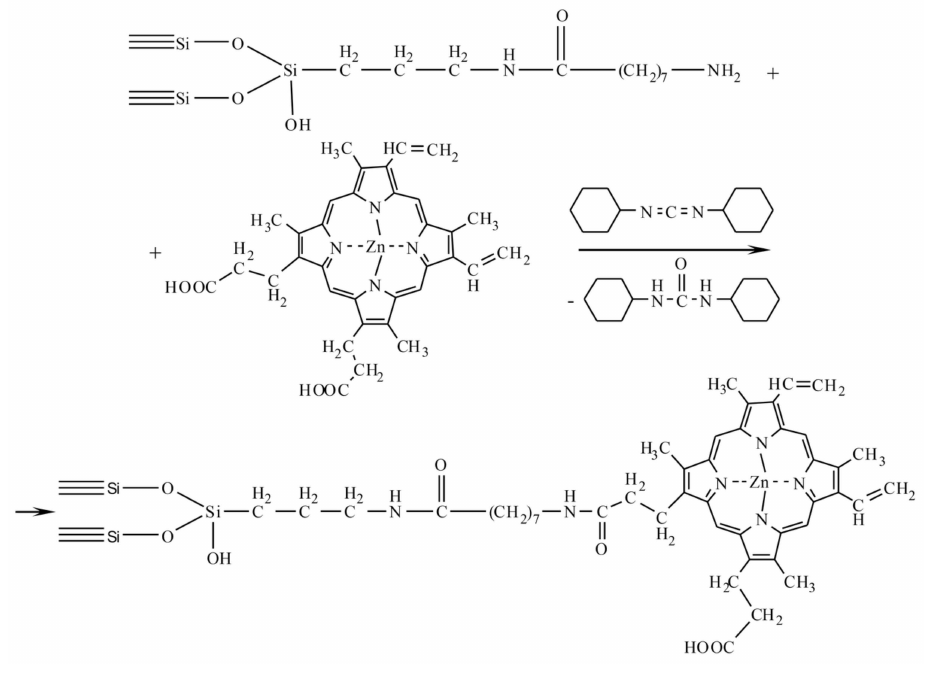
Figure 7. Immobilization of Zn-protoporphyrin.